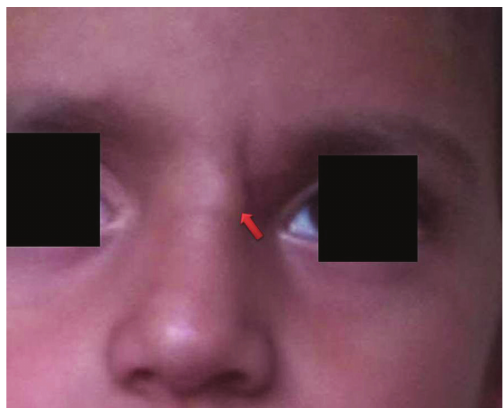
Figure 1: Photograph of patient showing slightly raised lesion on the forehead near the medial side of the left eyebrow.